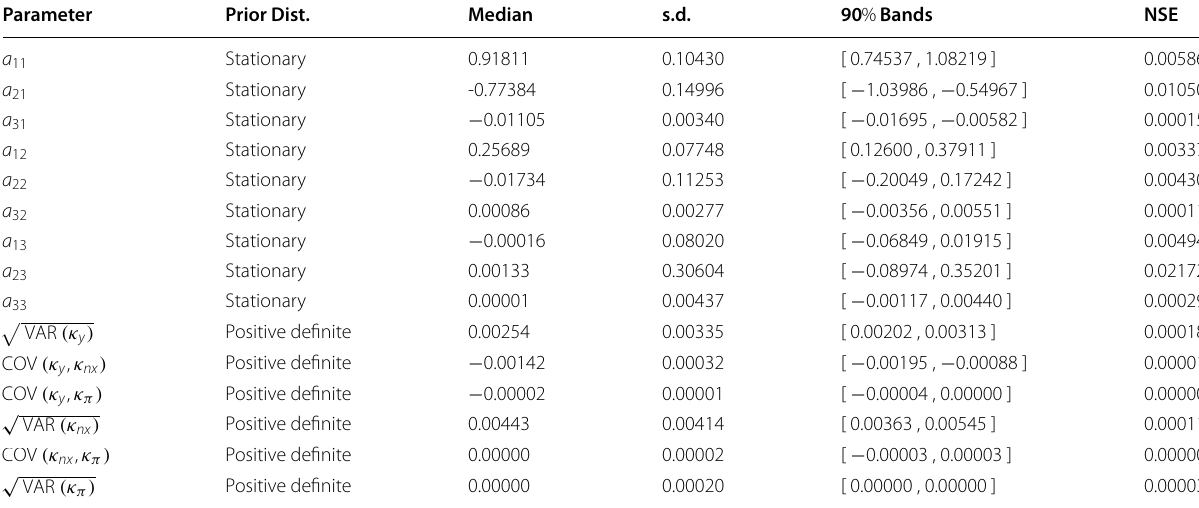
Table 3 Posterior Distributions of Non-Structural